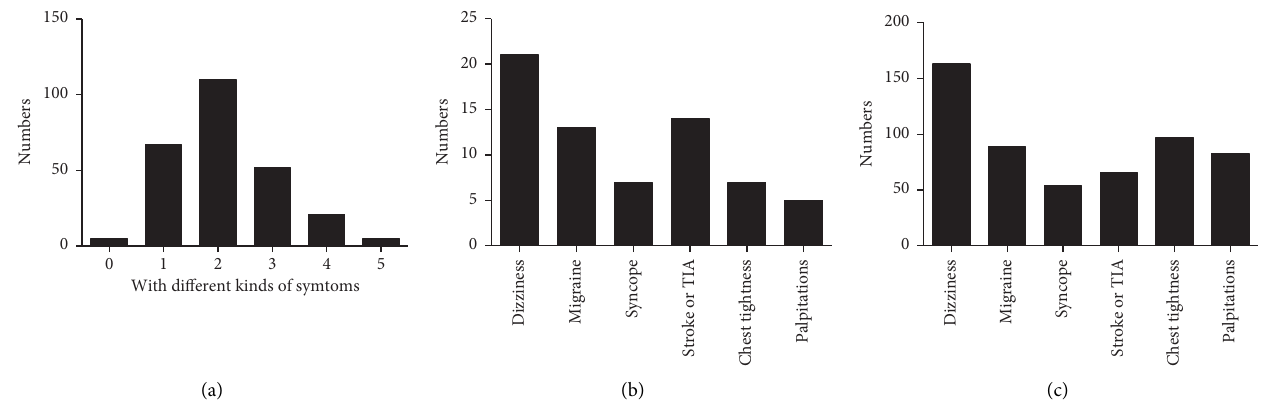
Figure 5: Composition of different kinds of symptoms. (a) The number of patients with different kinds of symptoms. (b) The composition of the 67 patients with only one symptom. (c) The number of patients with different